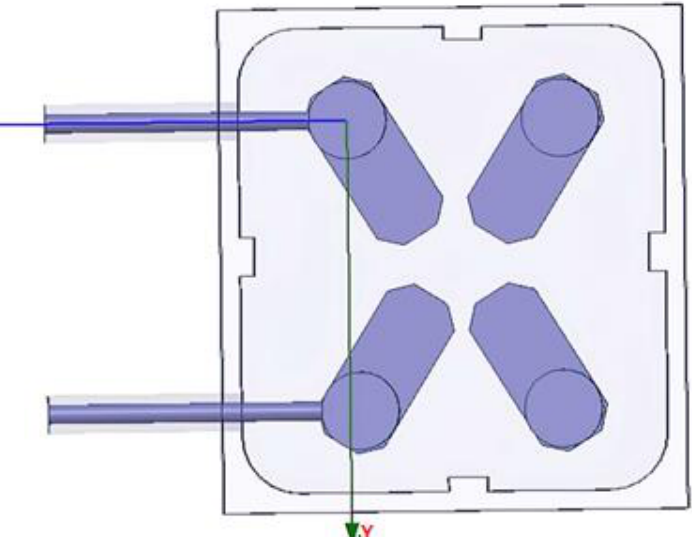
Figure 4. Proposed dimension of quadruple-mode resonator (top view).